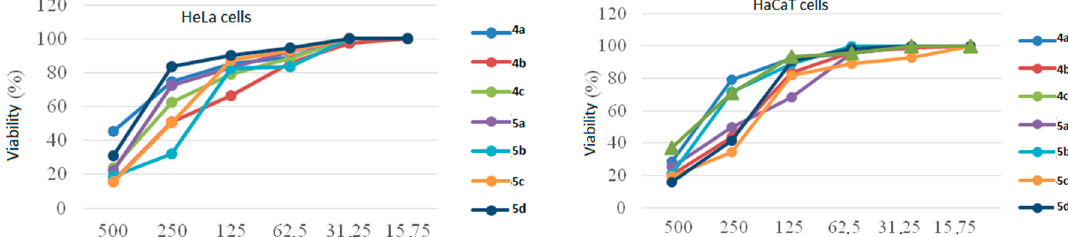
Figure 3. The cytotoxicity of compounds 4a – c , 5a – d on HeLa and HaCaT cells (evaluation at 48 h,